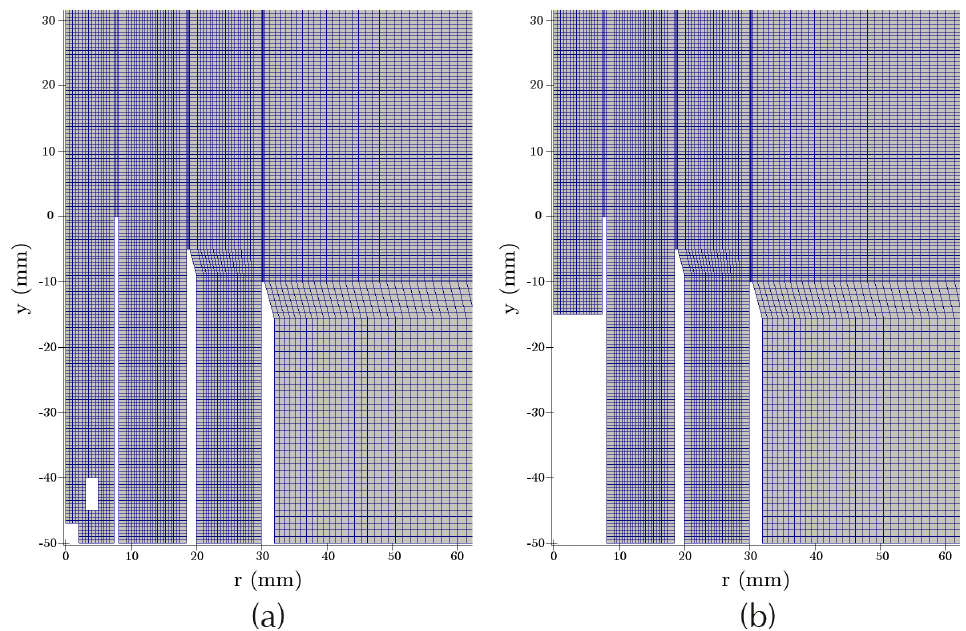
Figure 4. The computational mesh in the vicinity of the burner exit region for: ( a ) the non case A-i2; and ( b ) the reacting case